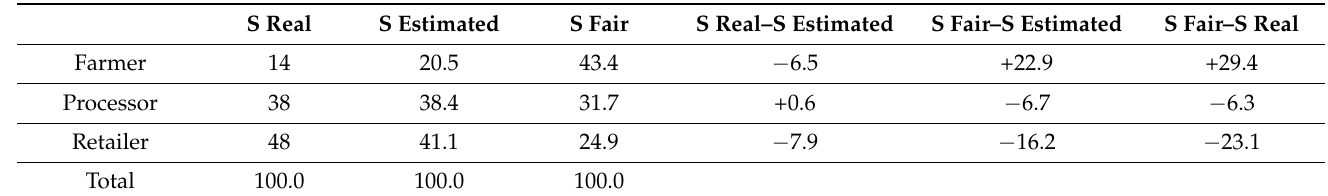
Table 5. Price real shares, estimated shares, and fair shares of the processed tomato product agro-food chain actors (%). S Real S